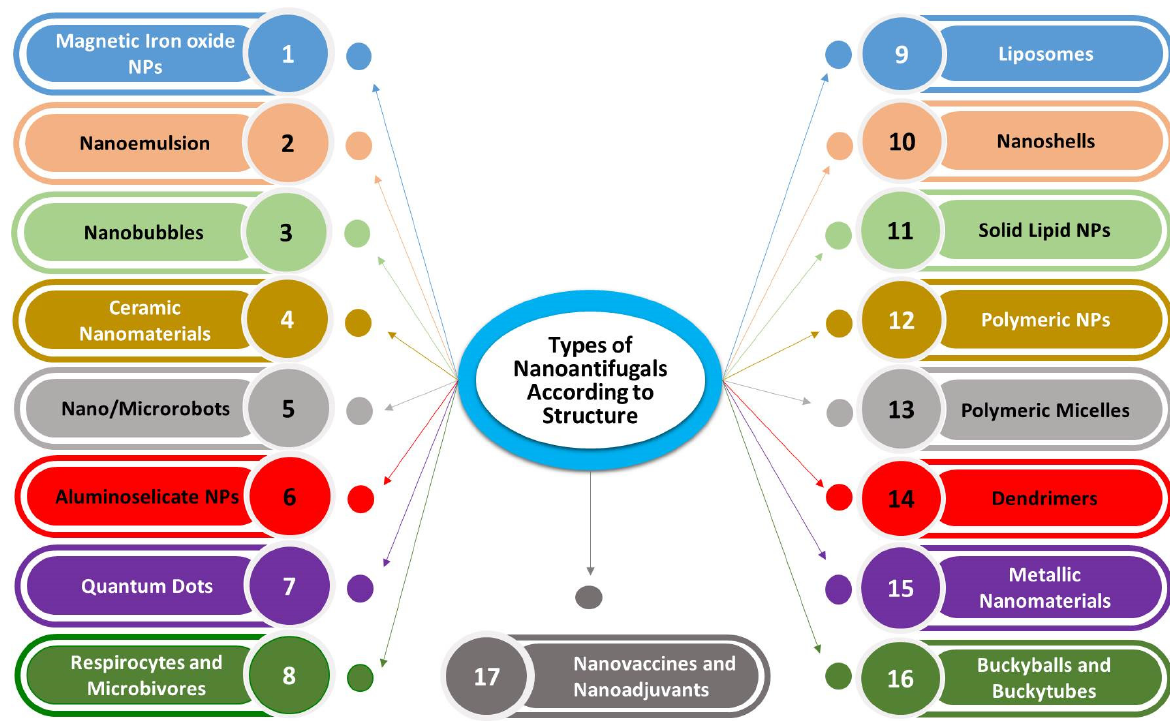
Figure 2. Various types of nano-based materials employed in antifungal nanotherapy in veterinary medicine.